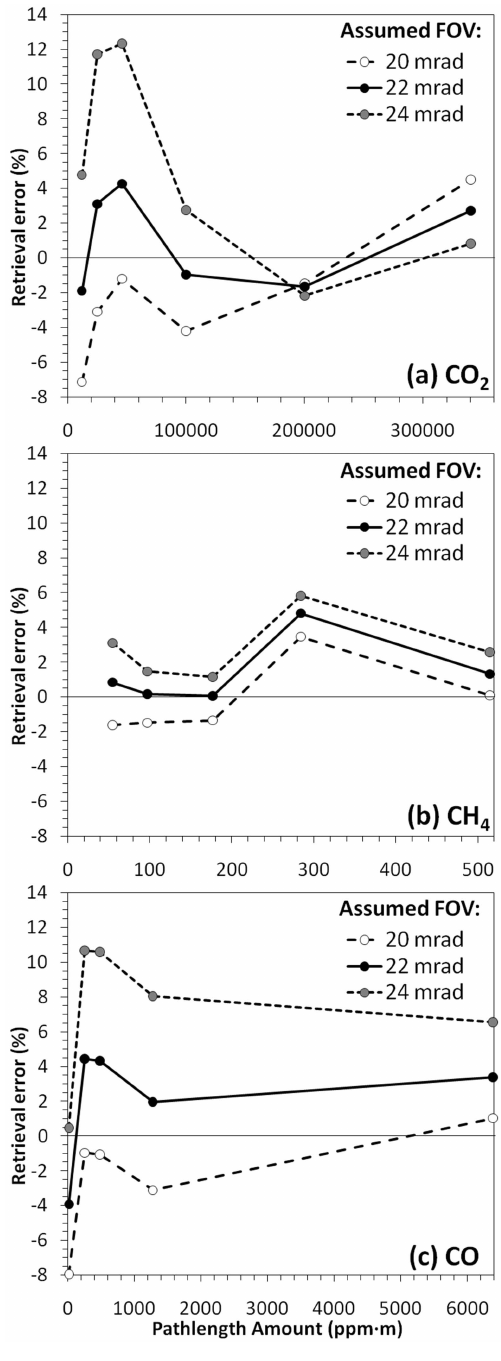
Fig. 9. Sensitivity of trace gas concentration retrieval error to the assumed FOV for (a) CO 2 , (b) CH 4 , and (c) CO. Retrievals were made using the MALT model with a NLLS fitting procedure. The same y-axis range is used in each case to aid comparison of error magnitude between